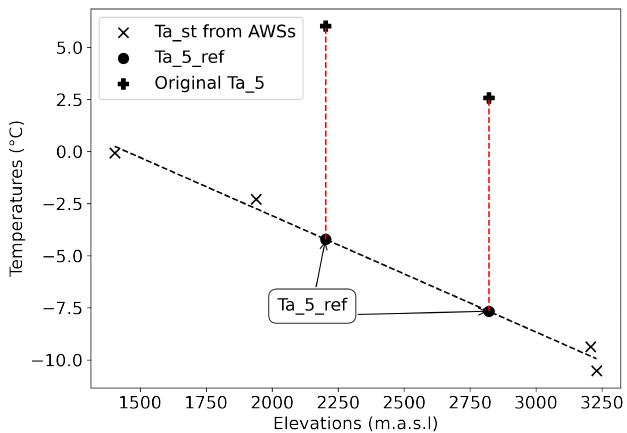
Figure 2. Example of Ta_5_ref estimates for ERA5-Land grid elevations based on observed hourly ELR_st (slope). The dashed black line represents the regression line of measured temperature to elevation. The red dashed lines show the difference of ERA5-Land Ta_5 to Ta_5_ref (what it should be). The Ta_st measured by AWSs are plotted against their corresponding elevations, and linear regressions are used to calculate the slope hourly ELR_st and the intercept b_st (representing air temperature at sea-level). These values are then used to interpolate hourly Ta_5_ref for elevations of ERA5-Land grid points (9 km spatial resolution) over the